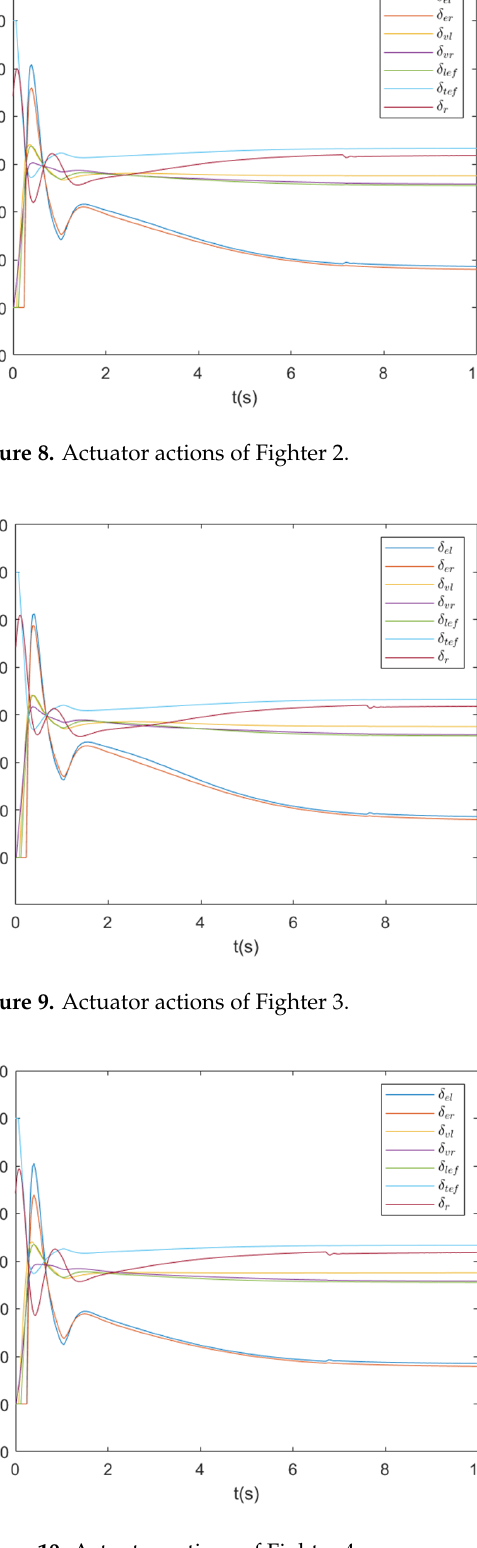
Figure 7. Actuator actions of Fighter 1.